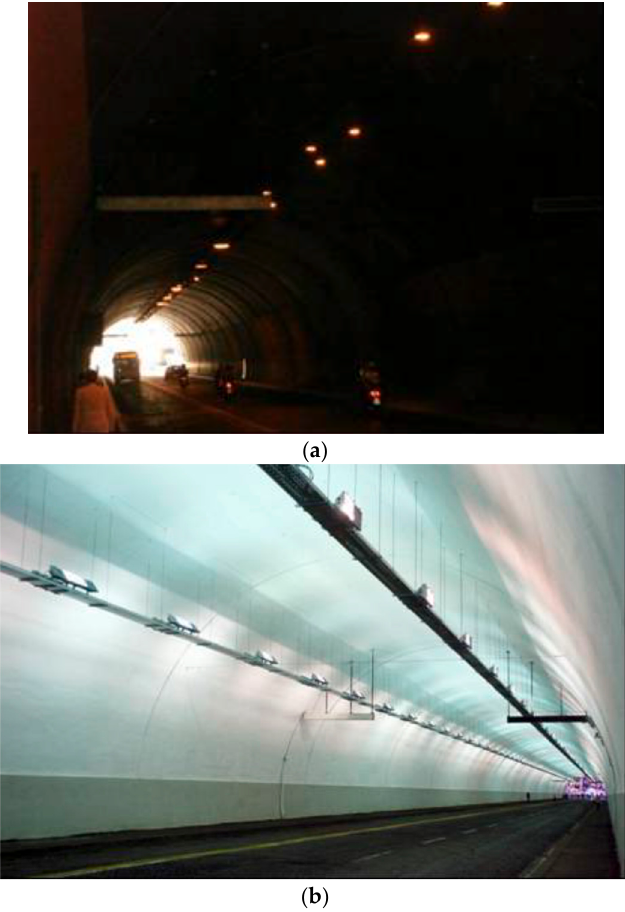
Figure 49 . ( a ) Conditions of the Umberto I tunnel in Rome (Italy) before the 2007 renovation; and ( b ) tunnel after renovation but before inauguration day of 9 September 2007. Reproduced from Guerrini and Peccati [123].